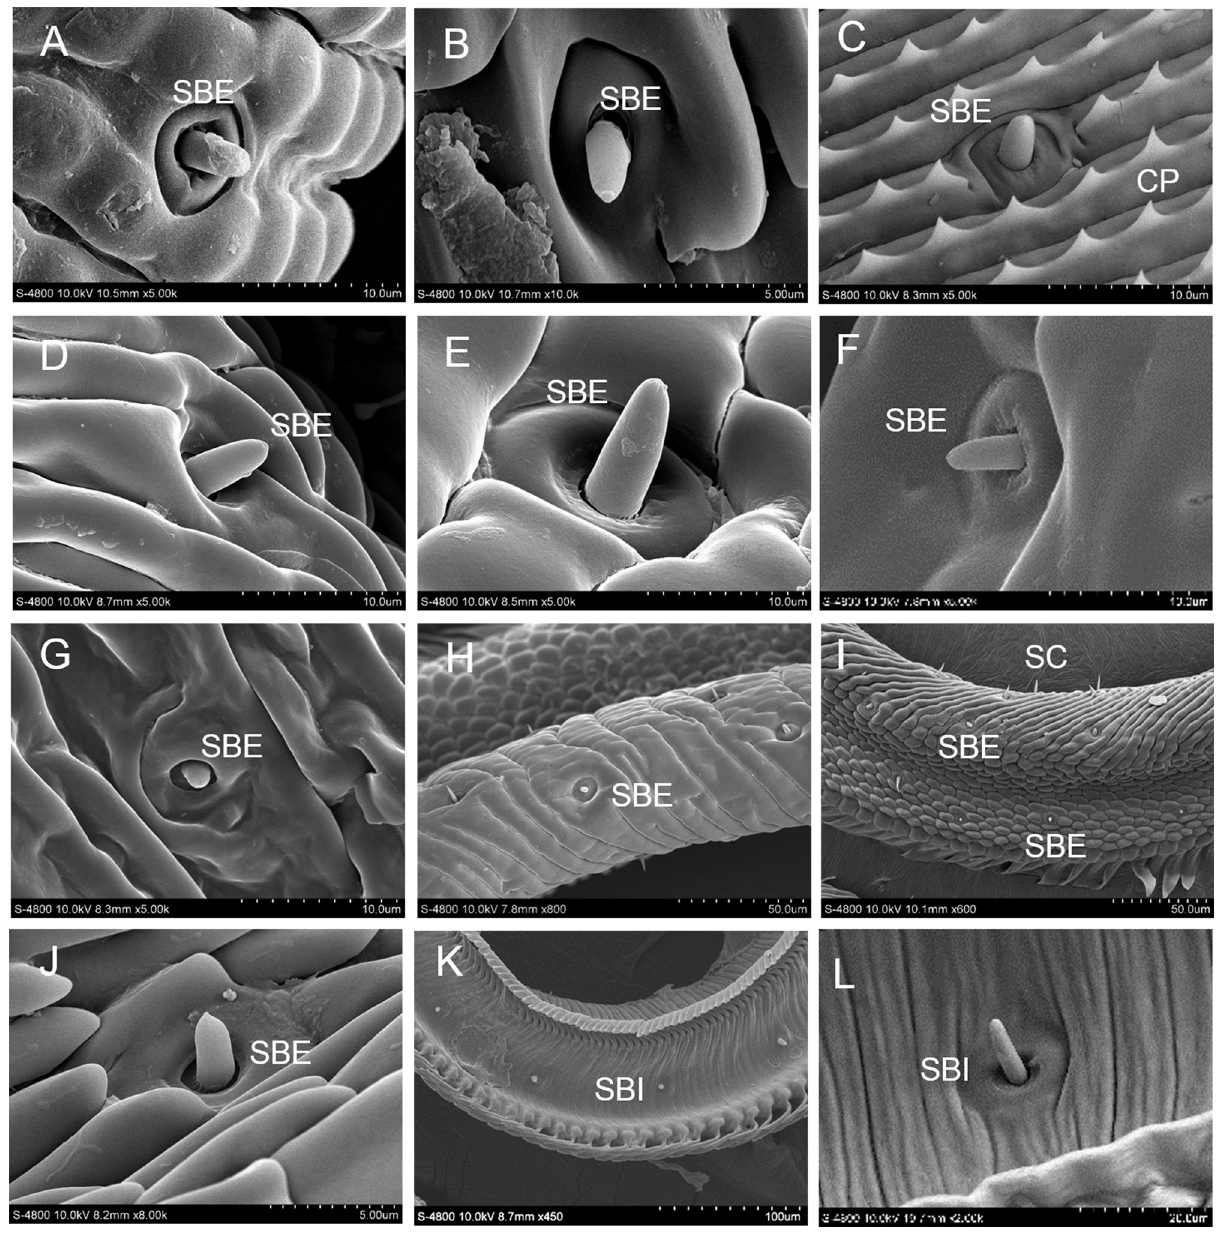
Fig 3. Sensilla basiconica (SB). A-J: An external sensillum basiconicum (SBE). A: I . podalirius ; B: P . guttata ; C: Co . fieldii ; D: Ce . oreas ; E: Sa . charonda ; F: T . limniace ; G: A . issoria ; H: St . neumogeni ; I: Ca . suroia ; J: L . celtis ; K: an internal sensillum basiconicum (SBI) in the food canal; L: magnification of